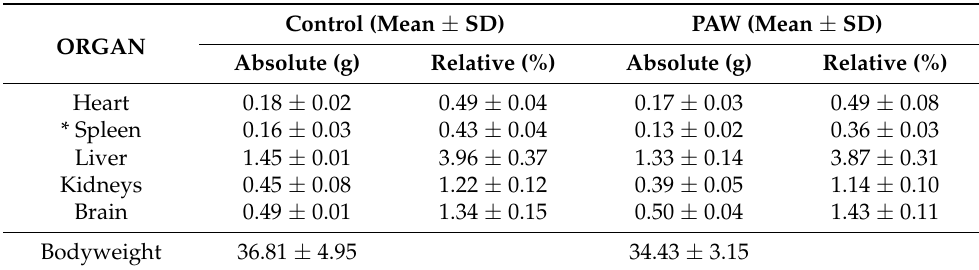
Table 2. The absolute and relative weight of the essential organs.